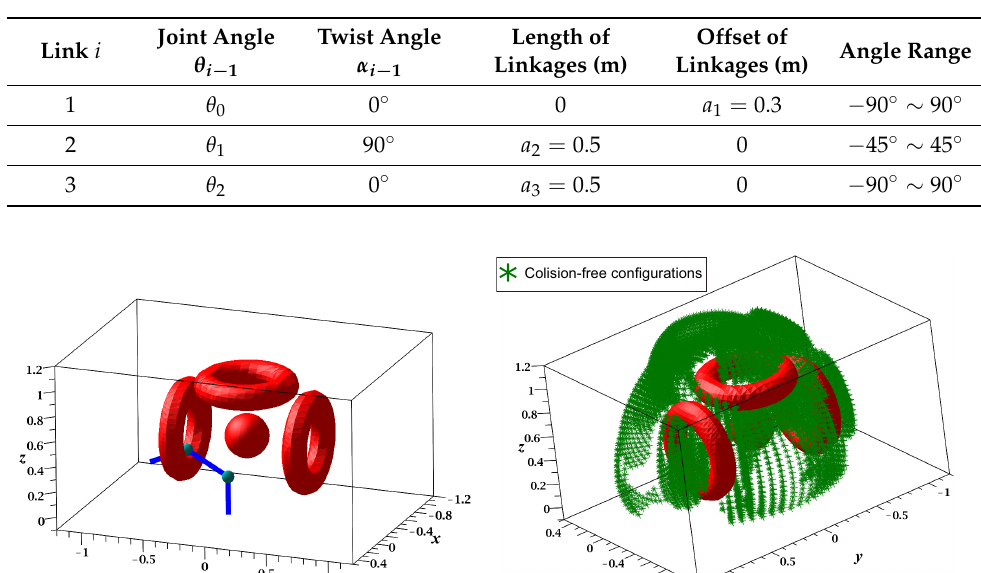
Figure 9. Dimensions and motion range of a 3 DOF manipulator. Table 2. D-H parameters of a 3 DOF manipulator.